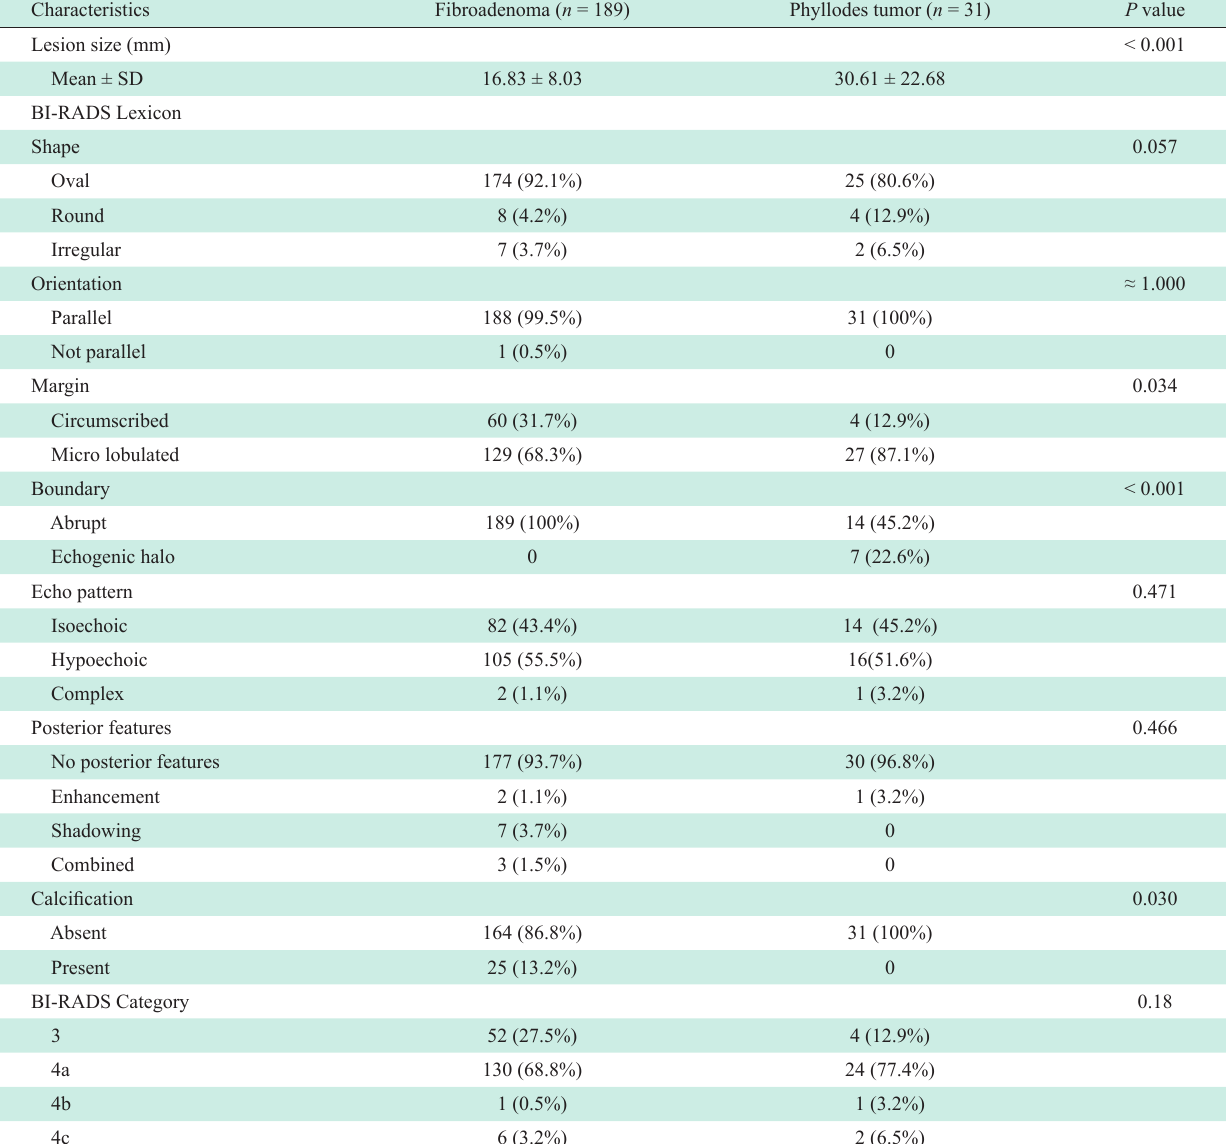
Table 1 B-mode US characteristics of fibroadenomas versus phyllodes tumors